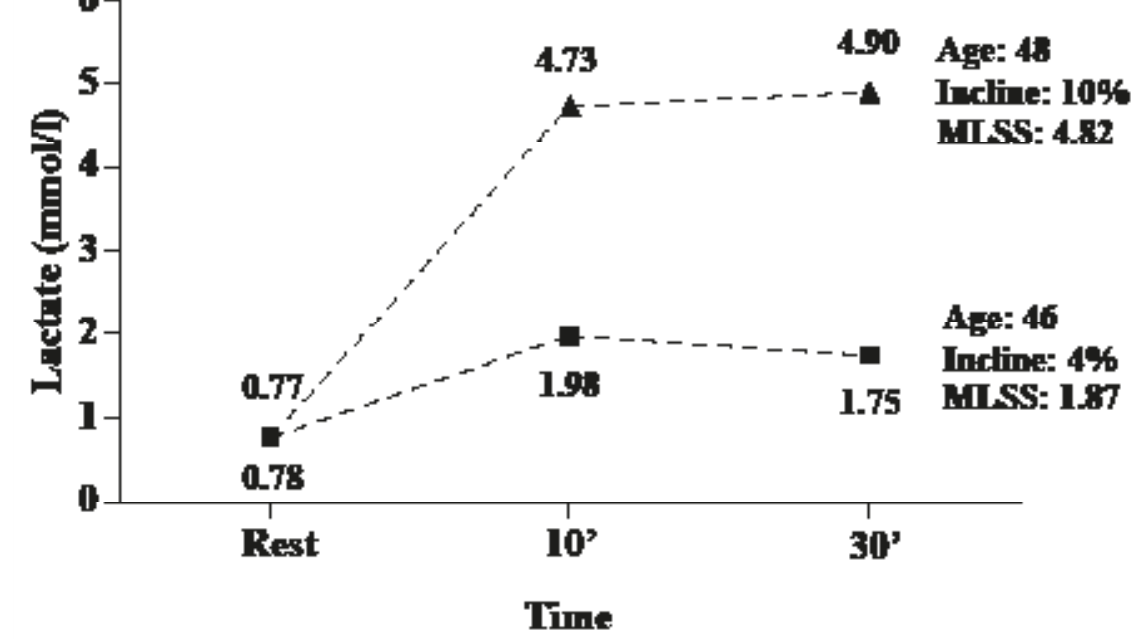
MLSS, maximal lactate steady